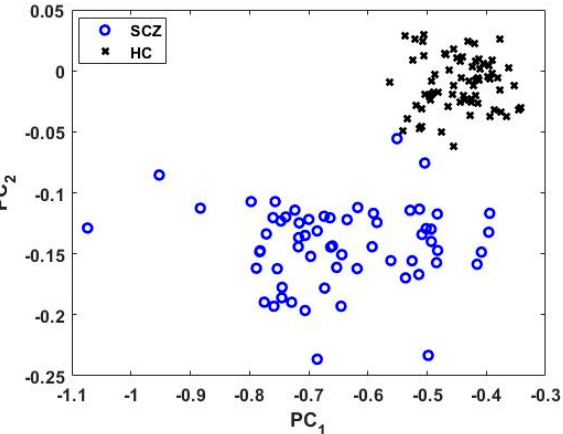
Figure 3. Scatter plot of the feature space showing SCZ (blue circles) vs. HC (black crosses). Table 4. Classification performance of different classifiers discriminating 14 SCZ from 14 HC sub- jects from dataset available at RepOD [ 58 ] using 5-fold CN-CV.